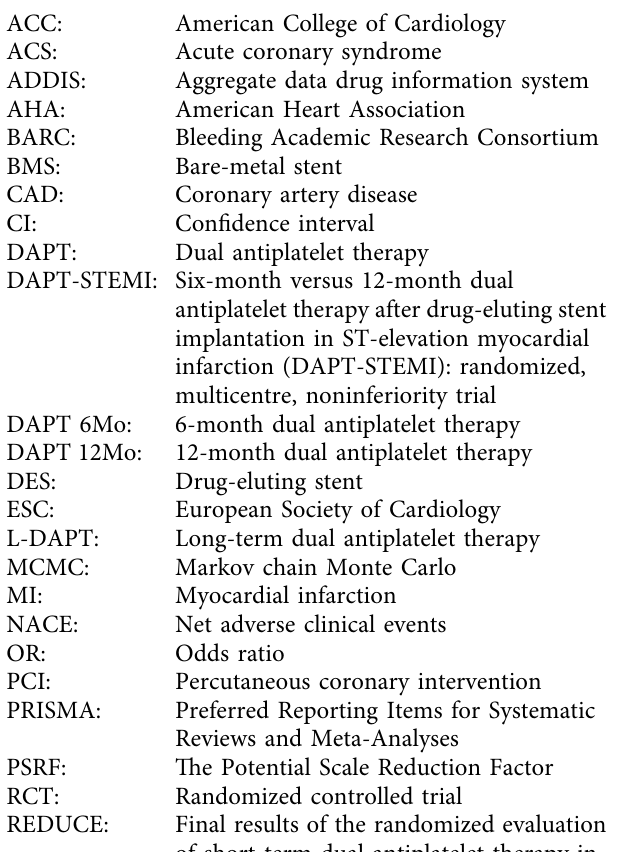
Supplementary Table S1. PRISMA checklist; Supplementary Table S2 . Individual search algorithm; Supplementary Table S4 . Baseline characteristics of participants; Supplementary Table S5. Definitions of clinical endpoints; Supplementary Table S6. The number of participants